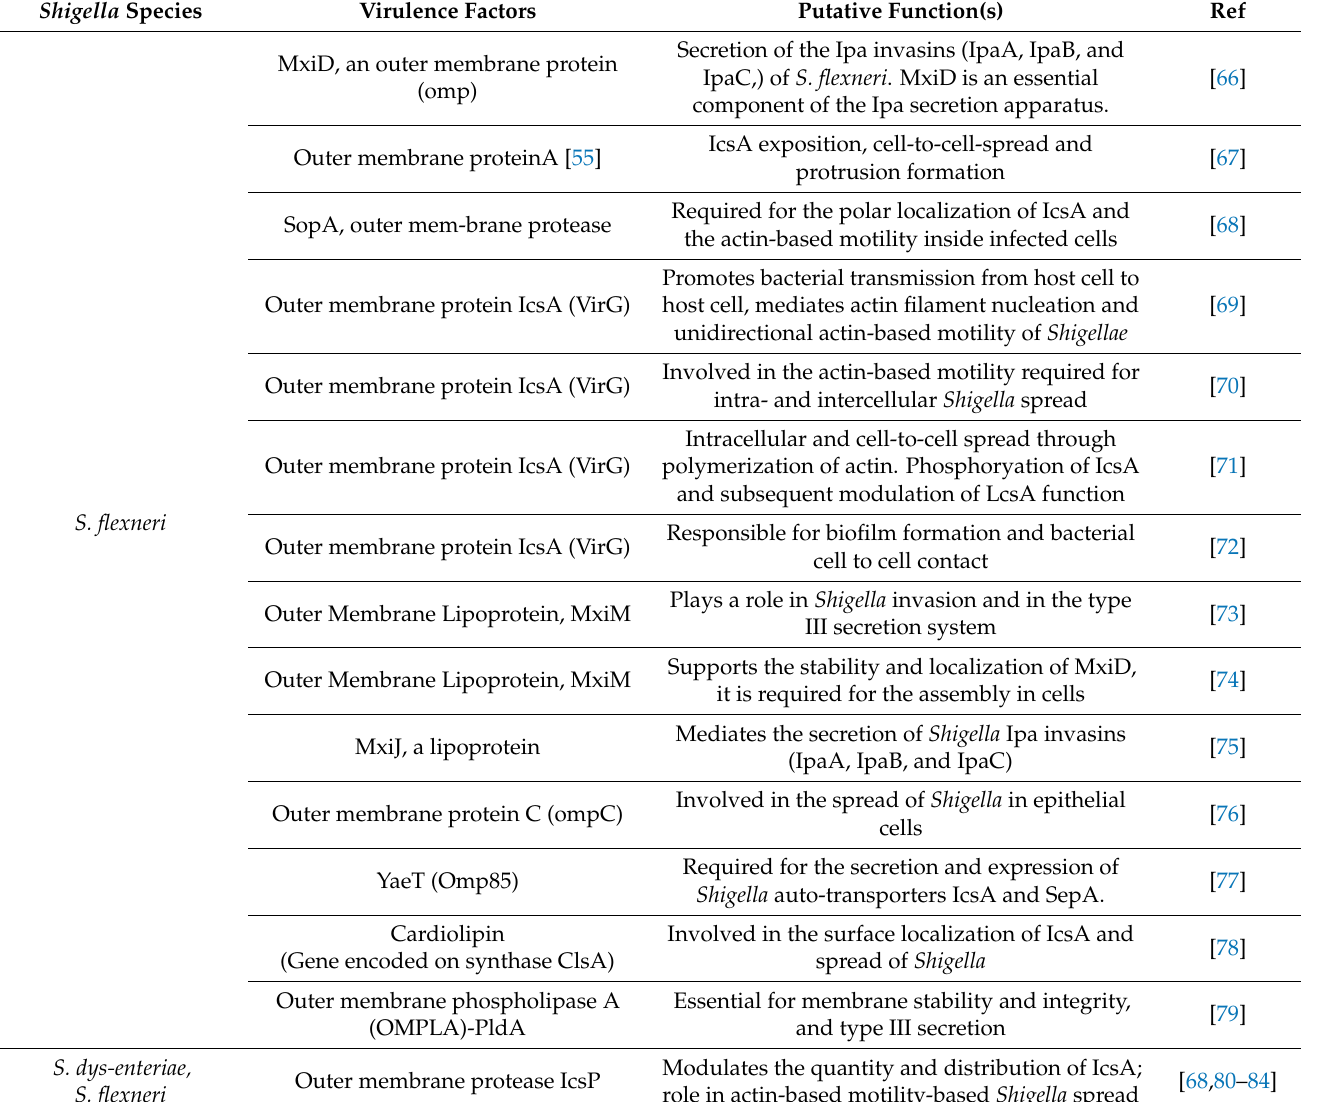
Table 3. Virulence factors of Shigella